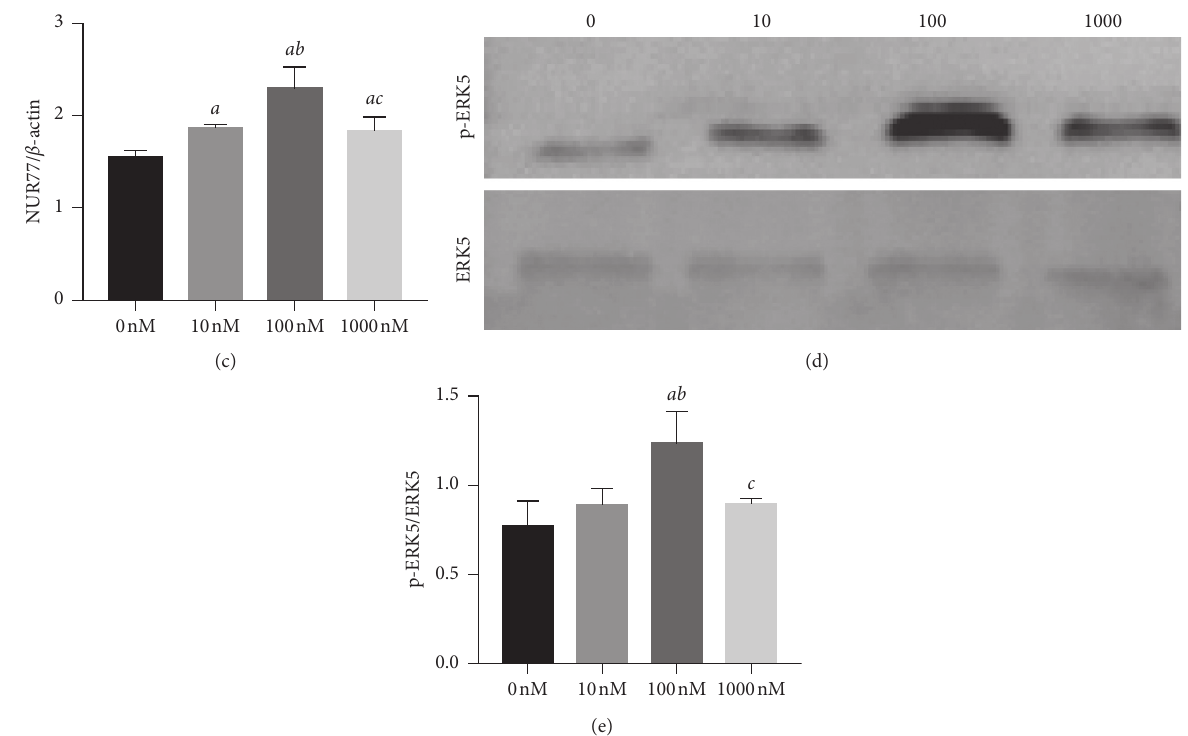
Figure 6: Liraglutide-activated ERK5 signaling pathway protein expression. MC3T3-E1 cells were treated with different concentrations of liraglutide for 48h, and then the protein expression of MEK5, NUR77, ERK5, and p-ERK5 was measured by western blot (a, d). Quantitative analysis of the protein level of MEK5 (b), NUR77 (c), and p-ERK5 (e) in MC3T3-E1 cells after treatment with liraglutide for 48h. aP < 0.01 compared with 0 nM, bP < 0.01 compared with 10nM, and cP < 0.01 compared with 100nM.